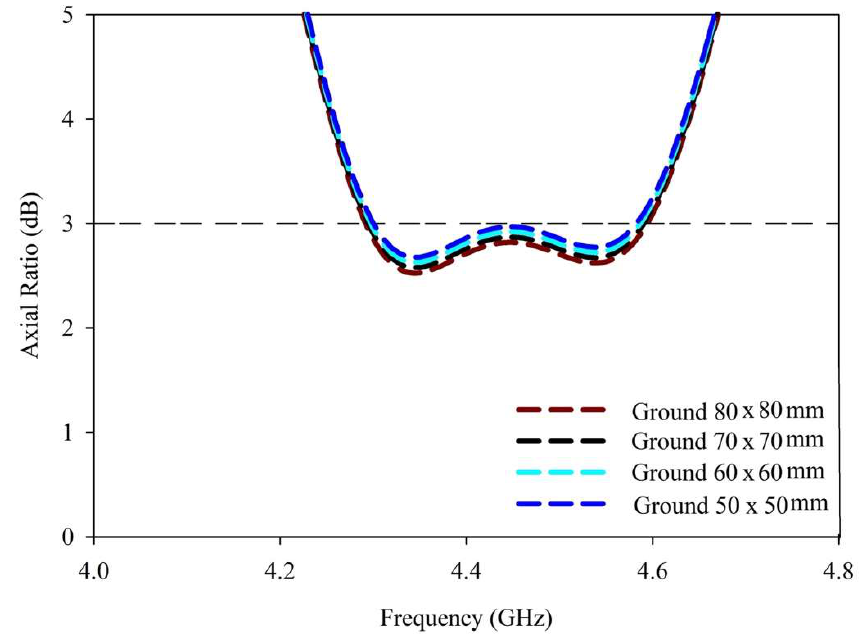
Figure 9. AR ratio of the CP 5G RDR with different ground plane sizes.